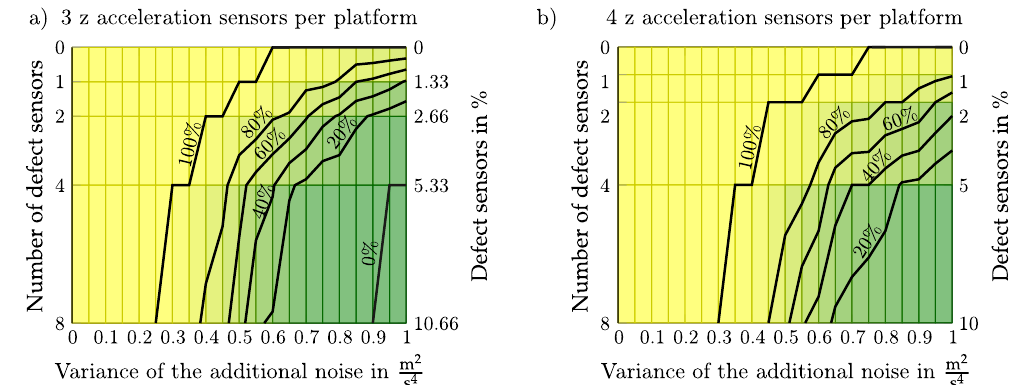
Figure 9. Impact of sensor precision degradation on the percentage of correct detected rope faults by the Extended Kalman Filter (EKF) rope fault estimation for a rope fault in rope number 1. ( a ) 3z acceleration sensors and ( b ) 4z acceleration sensors per platform are